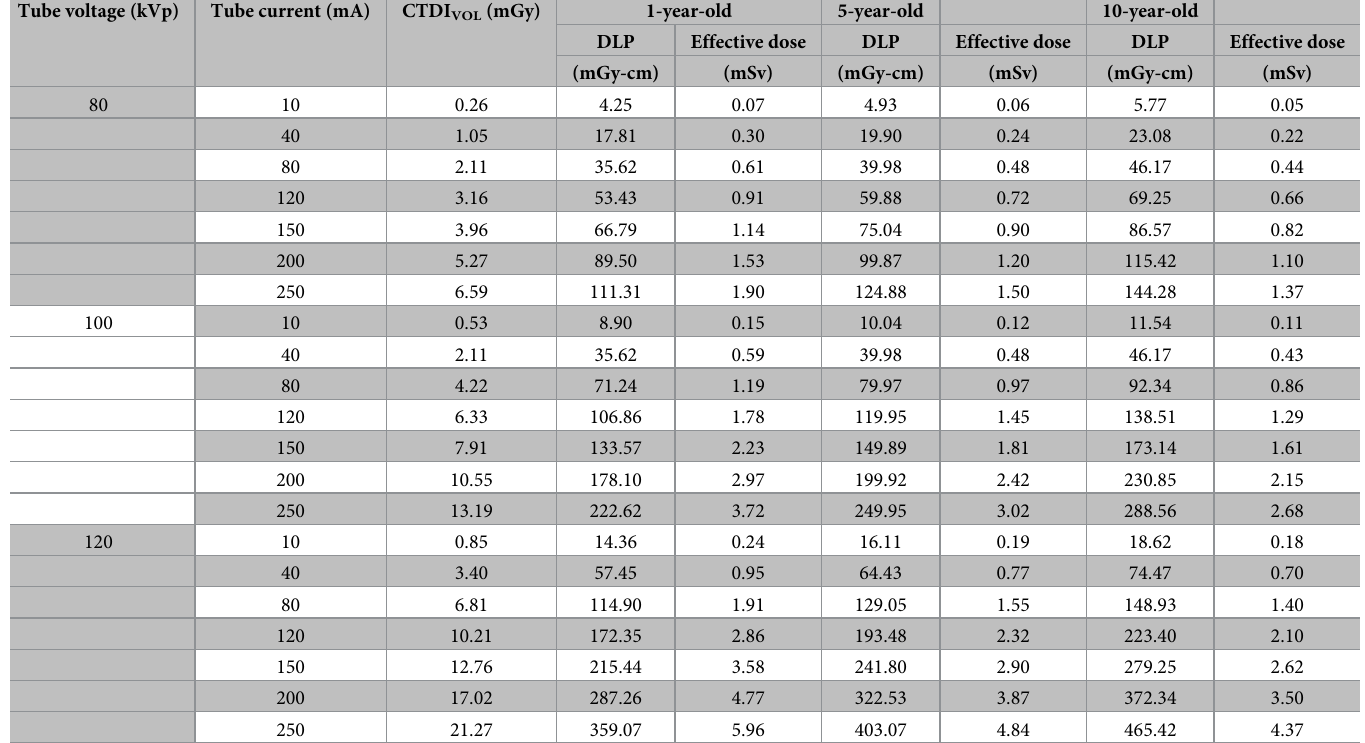
Table 1. Effective dose in anthropomorphic prostheses-based neck computed tomography scans, representing children aged 1, 5, and 10 years. Tube voltage (kVp) Tube current (mA) CTDI VOL